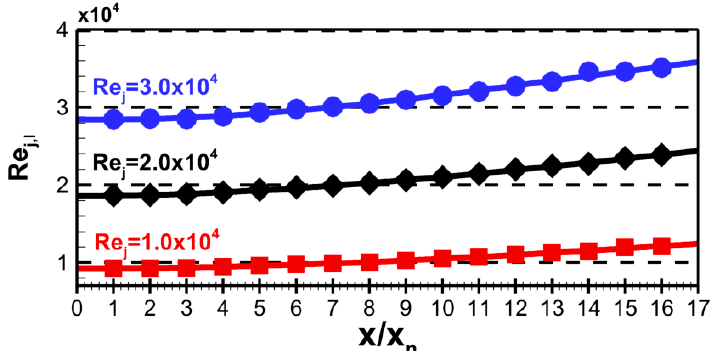
Figure 10. Local jet Reynolds number distributions at individual holes for the variable extended cases.